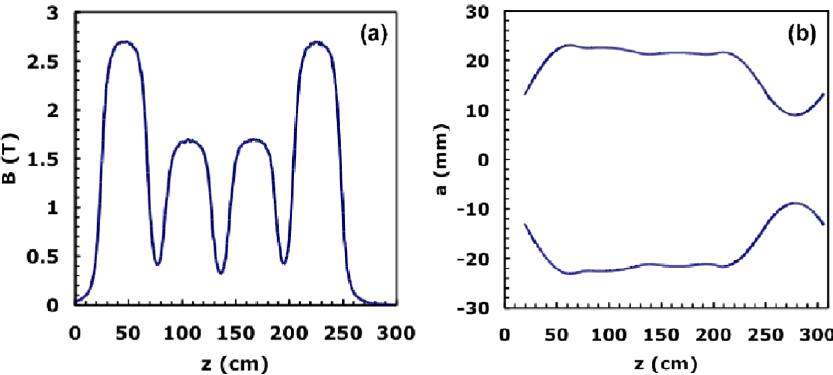
FIG. 12. (Color) (a) Axial magnetic field profile based on measurements; (b) calculated envelope of 45-mA beam.